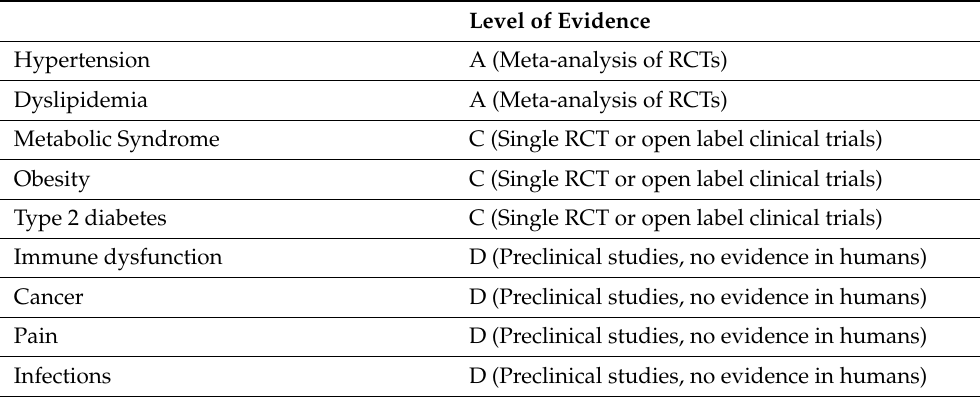
Table 1. Bioactive peptides and clinical